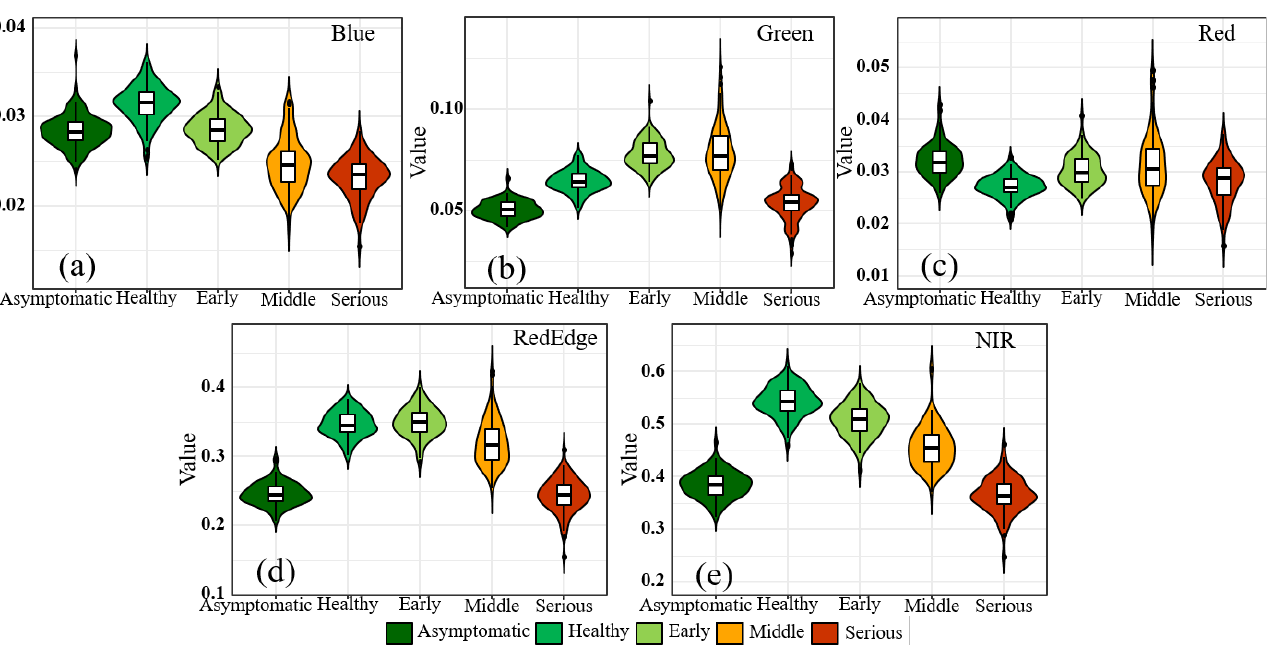
Figure 4. UAV multispectral spectral reflectance of rubber tree canopy infected with different degrees of powdery mildew disease: ( a ) blue band; ( b ) green band; ( c ) red band; ( d ) red-edge band (RE); ( e ) near infrared band (NIR).